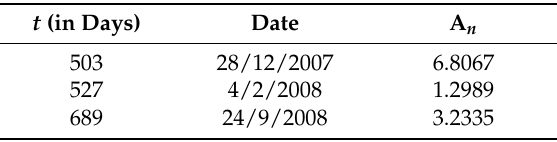
Table 14. Change points in the estimated bivariate jump time series of Intel with the corresponding test statistic value.